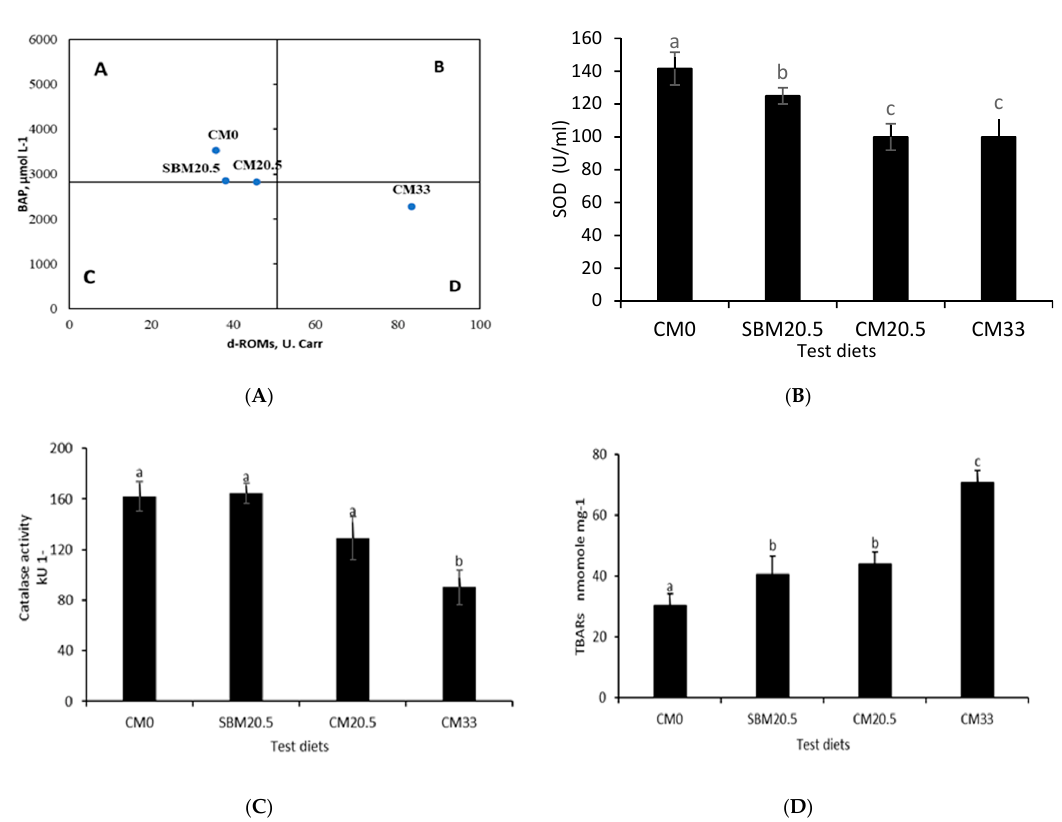
Figure 2. ( A ) BAP: Biological Antioxidant potential and d-ROM s; Reactive Oxygen Metabolites, ( B ) SOD; superoxide dismutase, ( C ) CAT, Catalase ( D ) TBARs: Thiobarbituric Acid Reactive substances (%, mean ± standard error, n = 3) of nutrients in red seabream fed diets formulated by replacing fish meal with camelina meal at 0% for reference diet (CM0), 20.5 g/kg with soybean mean (SBM20.5), 20.5 g/kg with camelina meal (CM20.5) and 33 g/kg camelina meal (CM33). Values with different letters are significantly different ( p <